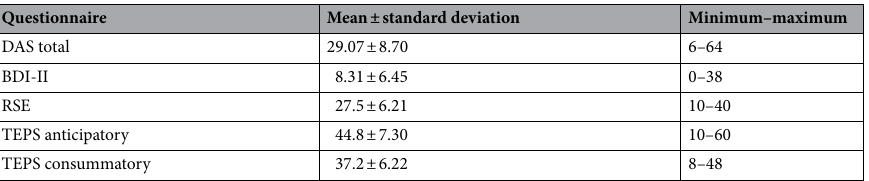
Table 1. Descriptive results of the validated questionnaires. DAS The Dimensional Apathy Scale (Radakovic and Abrahams 47 ), BDI-II The Beck Depression Inventory II (Beck et al. 52 ), RSE The Rosenberg Self-Esteem Scale (Rosenberg 53 ), TEPS The Temporal Experience of Pleasure Scale (Gard et al. 2006).